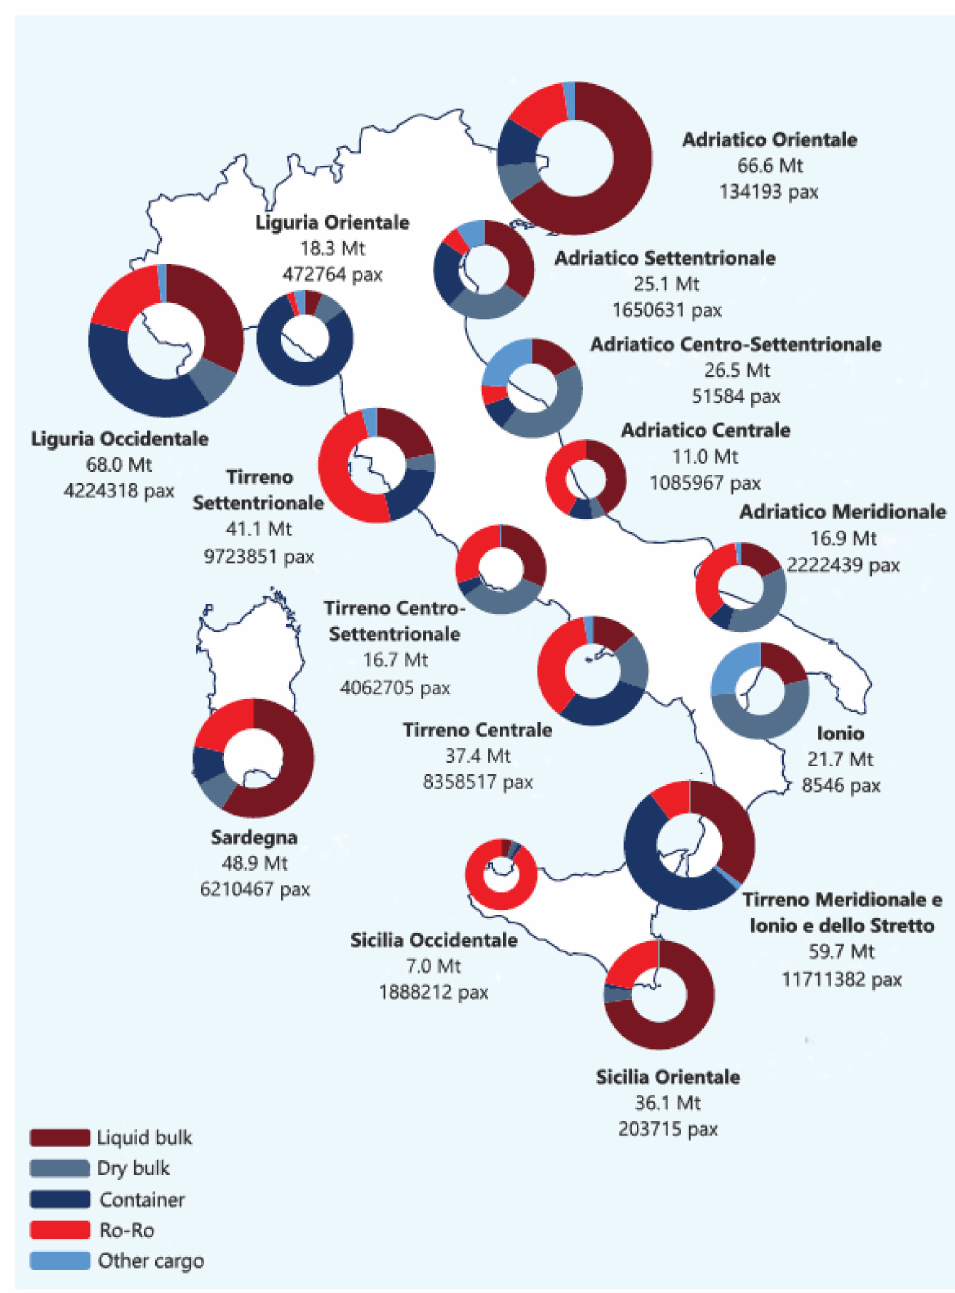
Figure 2. Merchant and passenger traffic volumes for the 15 Italian port